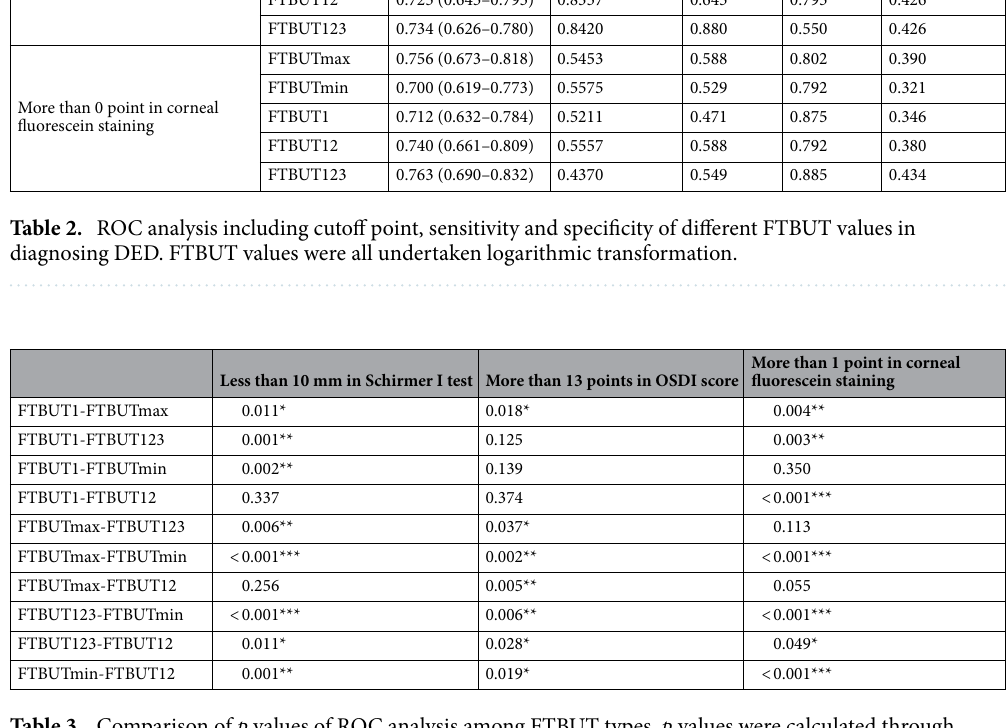
Table 3. Comparison of p values of ROC analysis among FTBUT types. p values were calculated through Medcalc. * p < 0.05, ** p < 0.01, *** p <